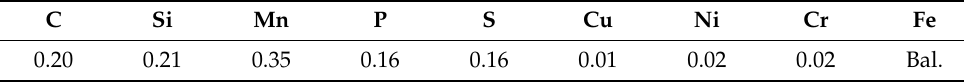
Table 1. Chemical composition of AISI 1020 steel used in this study (mass %).